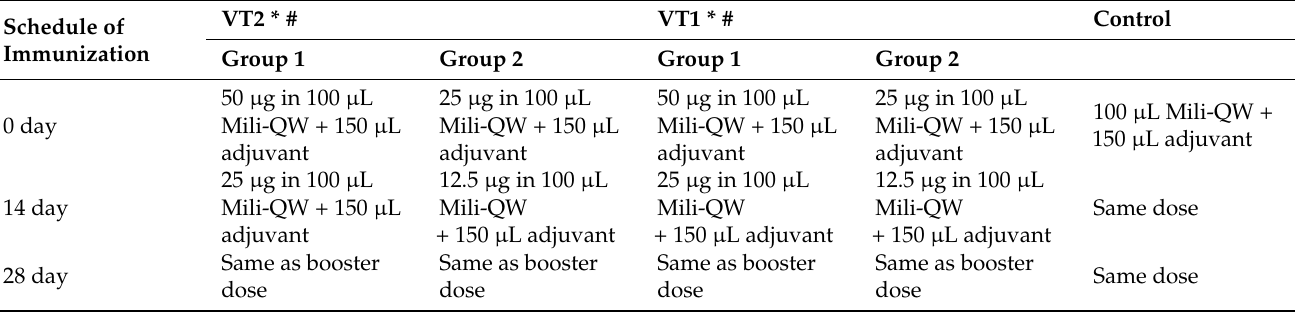
Table 1. Immunization schedule, dose, adjuvant used, route of immunization of rabbits using VT2 and VT1